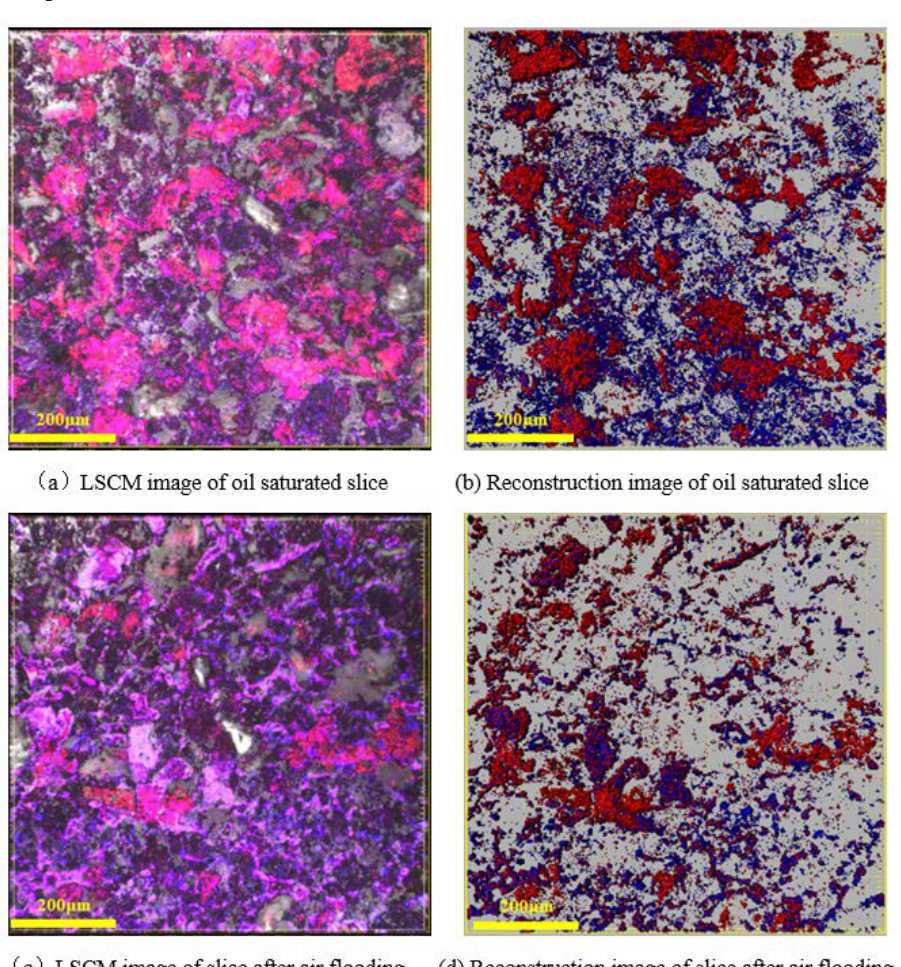
Figure 13. LSCM images of slices in different states and the corresponding reconstruction images. (Red regions: light components of crude oil, which may include pyrolysis gas (<nC12), gasoline (nC10–nC16) and some kerosene (nC11–nC19); blue regions: heavy components of crude oil, which may include some Kerosene (nC11–nC19), diesel (nC14–nC22), heavy oil (nC16–nC26); Pink regions: the superposition of light and heavy components; Black regions: the matrix.).